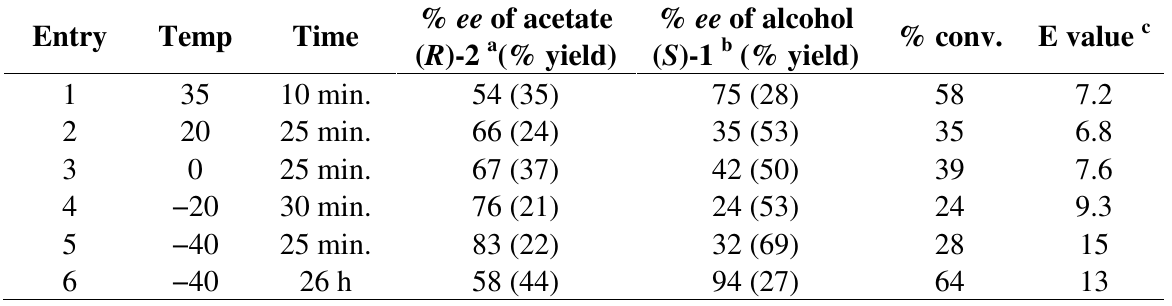
Table 1. Results of lipase QLM-catalyzed transesterification of (±)- 1